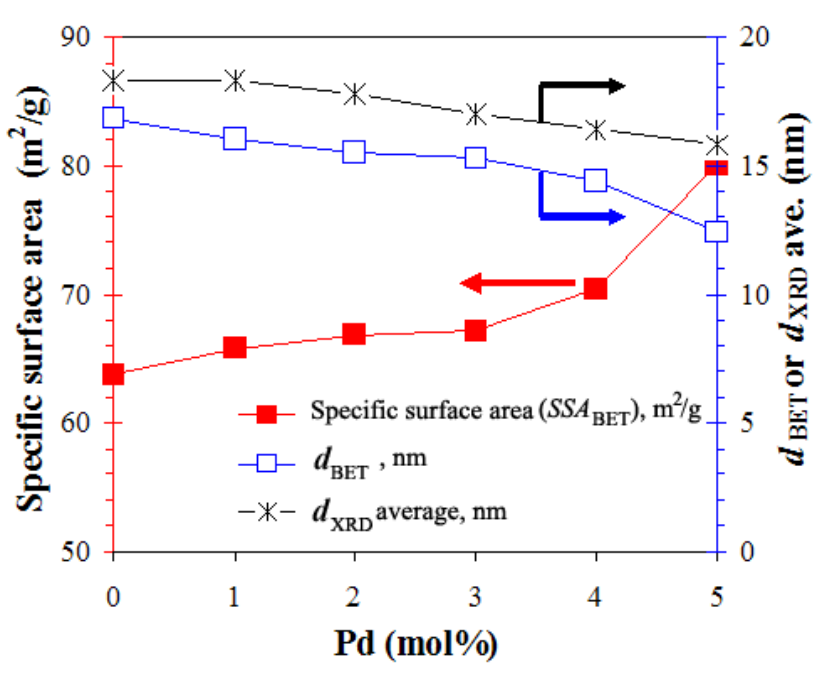
of Pd concentration for samples